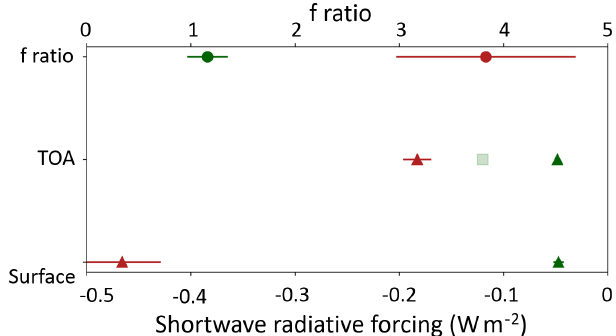
Figure 6. Daily average clear-sky top of the atmosphere (TOA) and surface direct radiative forcing (triangles), and f ratio (dots), for the mean fire plume and ATAL profiles of Fig. 2a. Green represents the calculations for the ATAL, red for the fire. The variability of the SSA in our calculations is reflected by the error bars. The clear- sky TOA radiative forcing estimation for the July–August ATAL of Vernier et al. (2015) is also shown (semi-transparent green